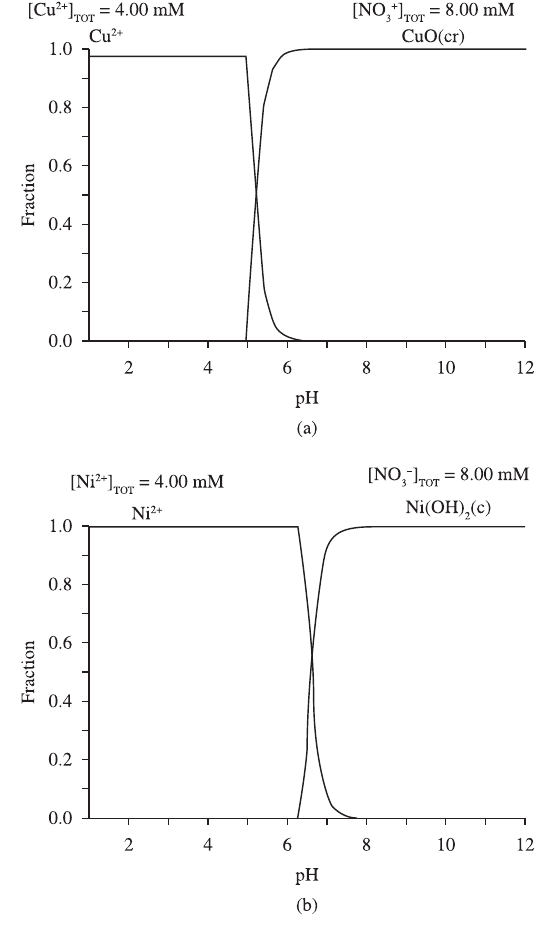
Figure 2. a) Cu 2+ ; and b) Ni 2+ speciation in adsorption as a function